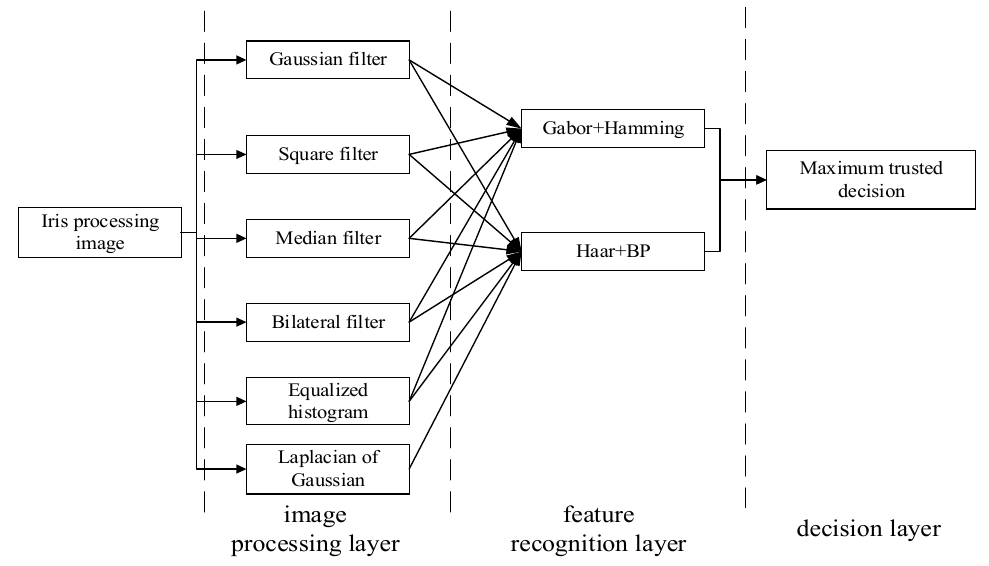
Figure 6. Overall process of the algorithm.